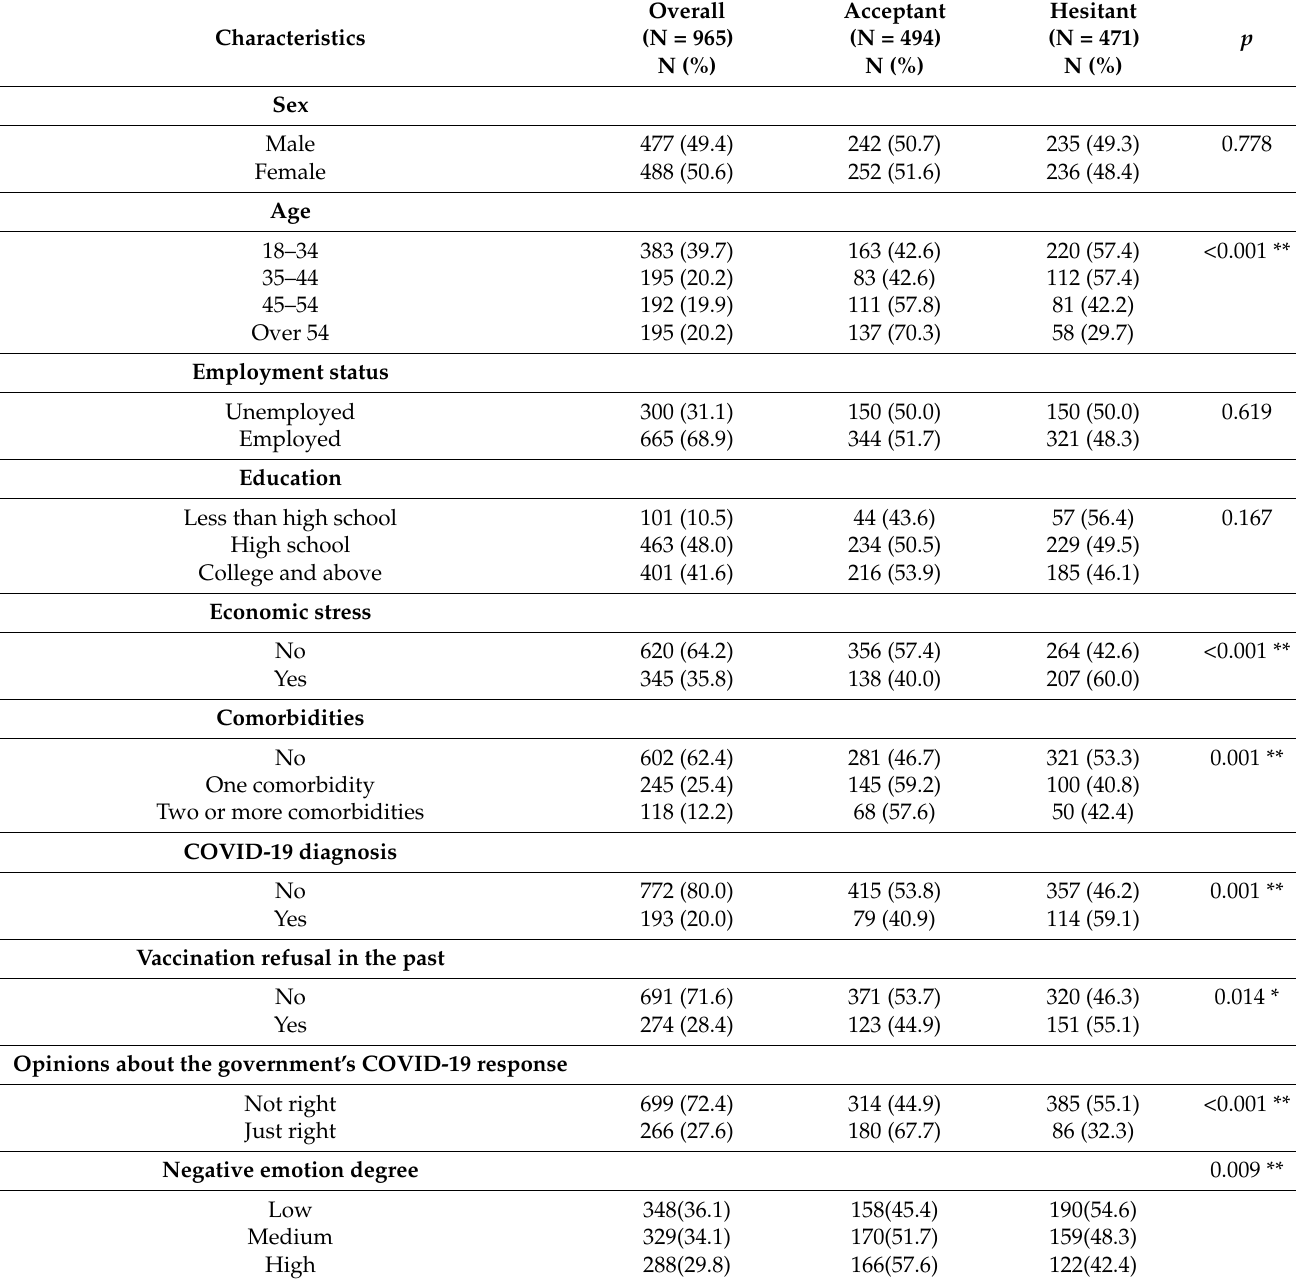
Table 1. Baseline characteristics and their relationships with vaccine